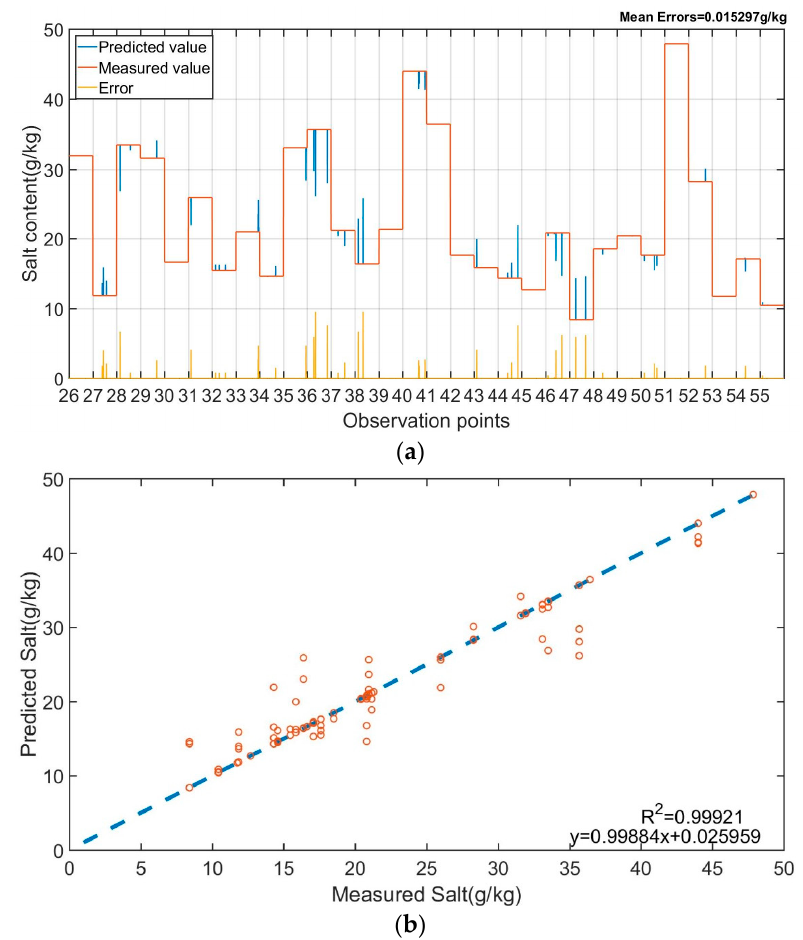
Figure 9. PNN model prediction results in Area B: ( a ) under different observation points; and ( b ) linear fitting.